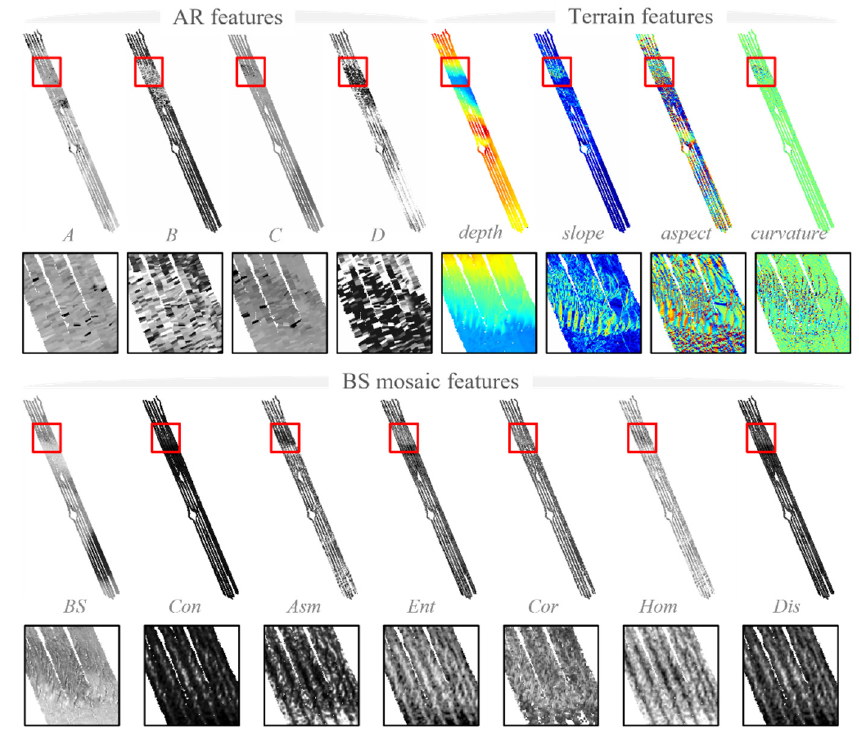
Figure 6. Feature mosaics.